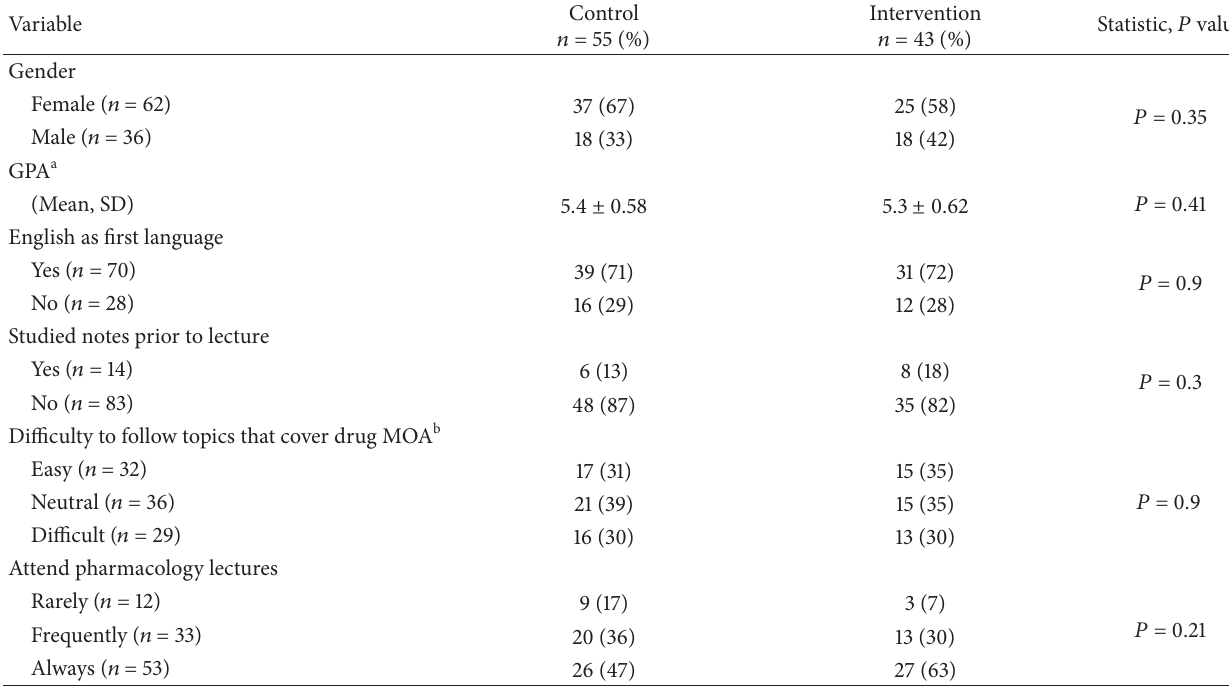
Table 2: Student demographic data and behaviour in the Human Pharmacology courses (obtained in phase 1).